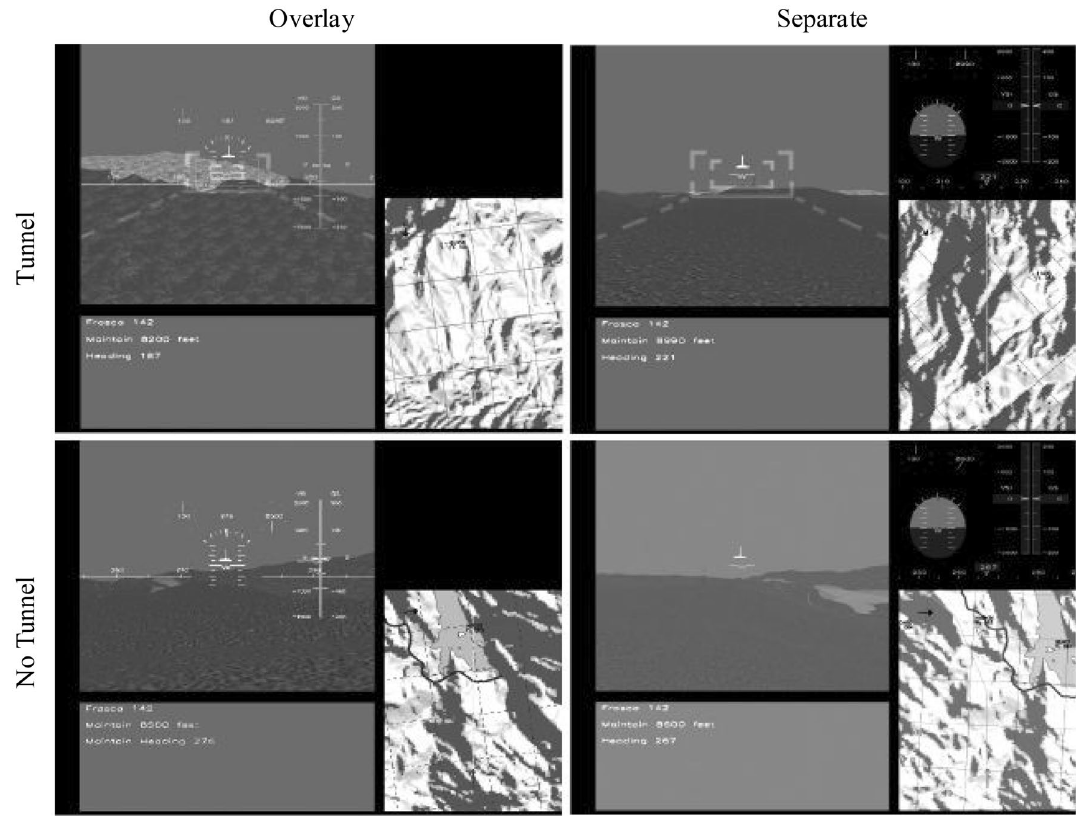
Figure 5. Four display suits defined by the characteristics of overlay versus separate, and tunnel versus no tunnel 32 .